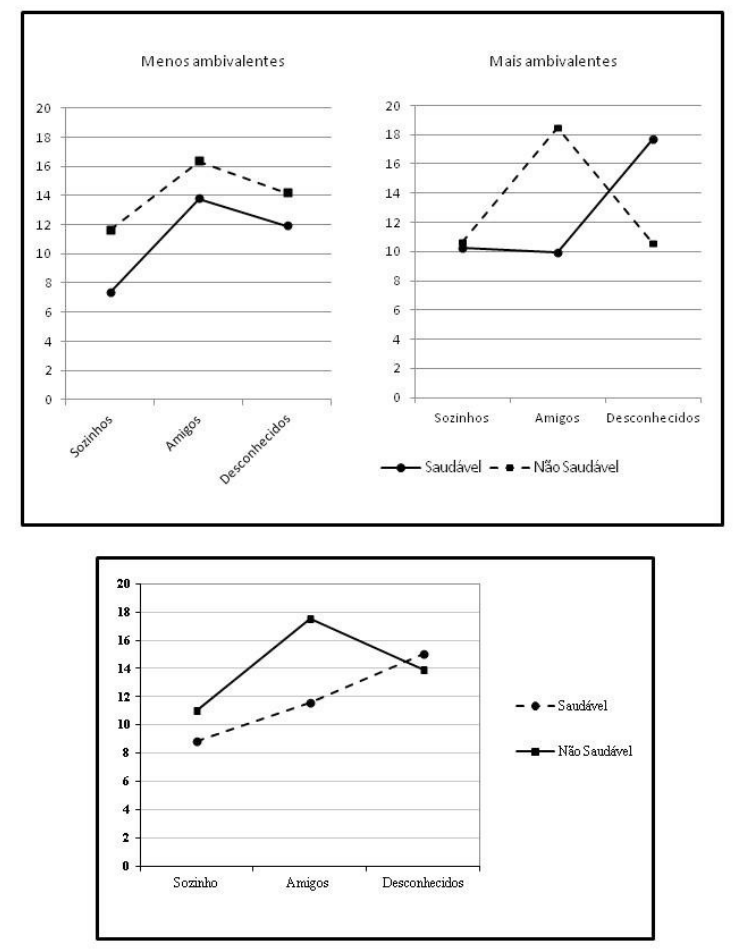
Figura 1 . Quantidade de alimentos consumidos em função do contexto so- cial, da qualidade dos alimentos e da ambivalência (em cima) e quantidade de alimentos consumidos em função do contexto social e da qualidade dos alimentos (em